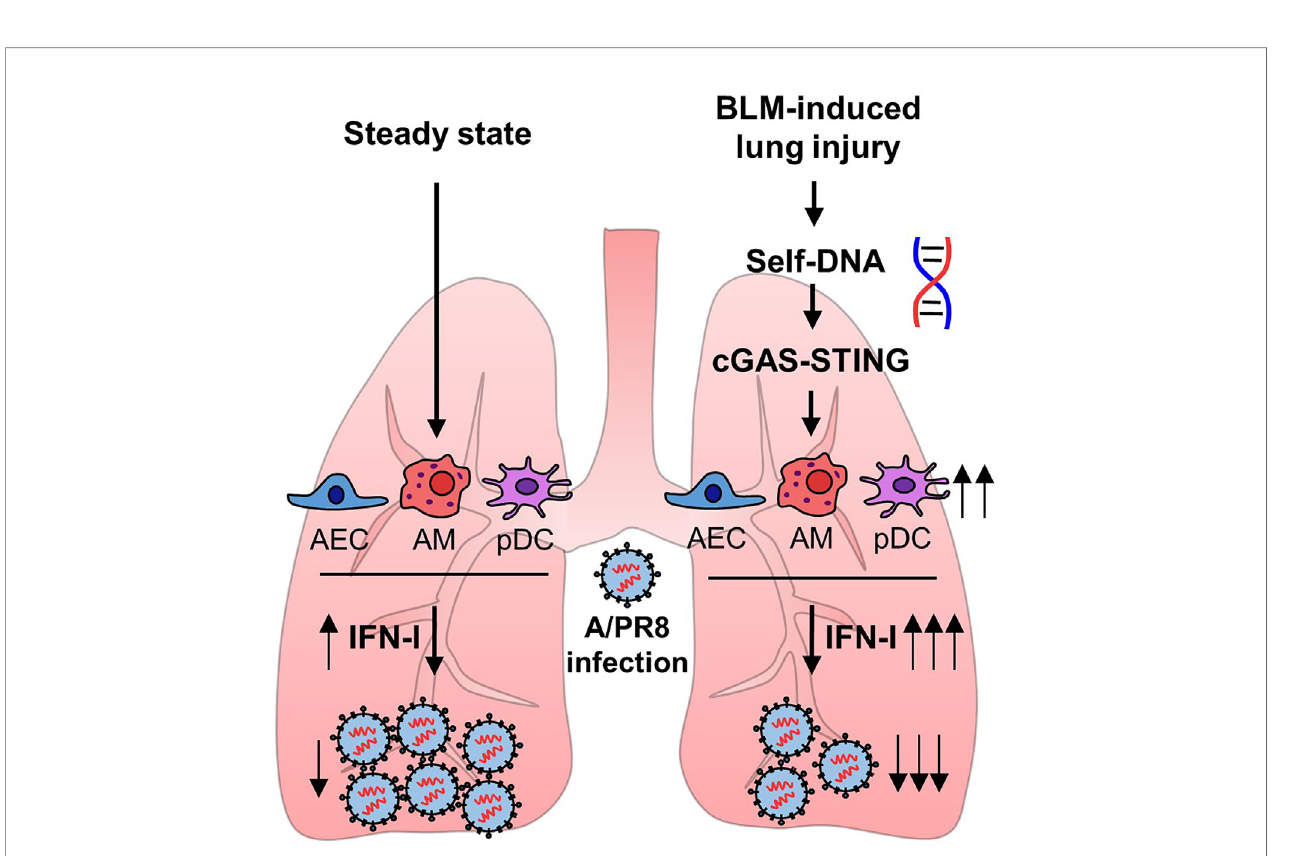
FIGURE 7 | Bleomycin-induced lung injury releases self-DNA that activates cGAS-STING pathway. Activated cGAS-STING pathway affects to enhanced IFN-I transcription, and pDCs are responsible for increased antiviral